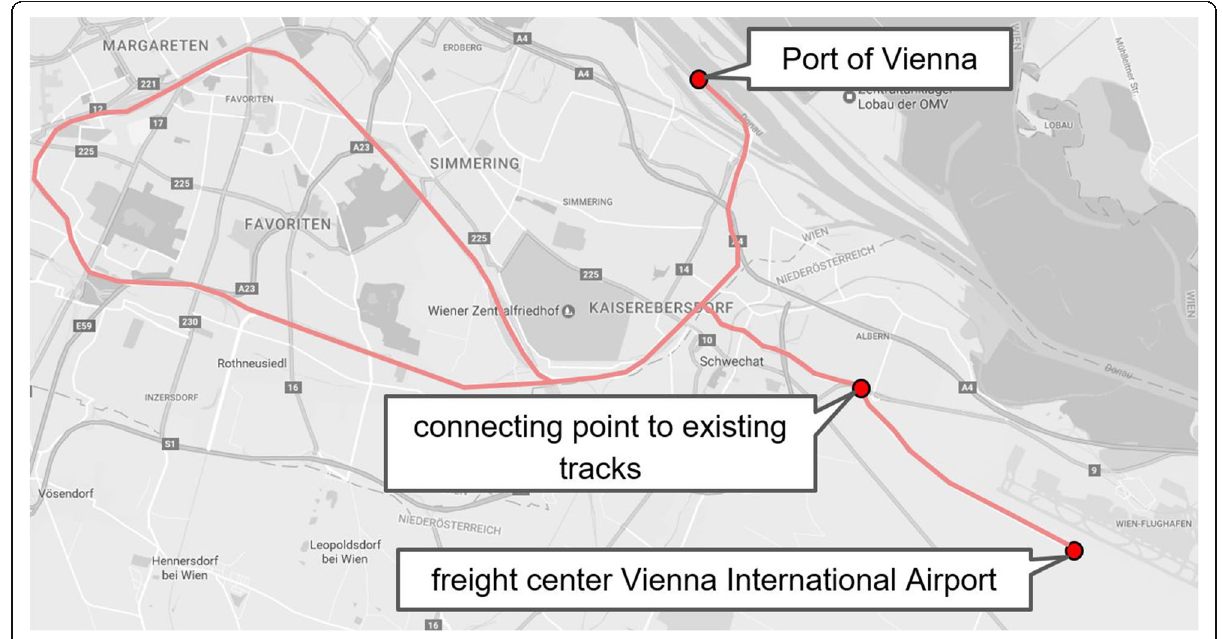
Fig. 3 Overview about the planned and existing railway connections the